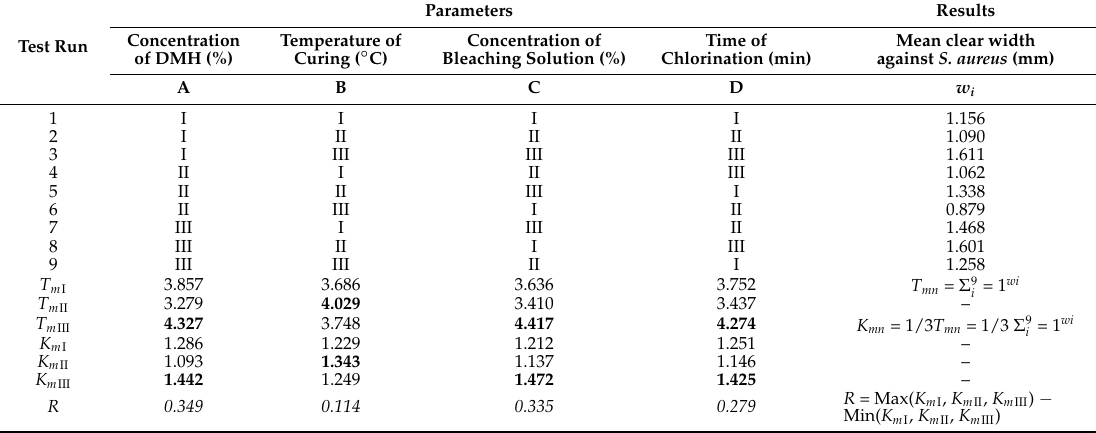
Figure 3. Example of the clear zone of the sample against bacteria [24]. Table 3. Orthogonal table for optimizing the antibacterial property of cotton fabric coated with DMH.